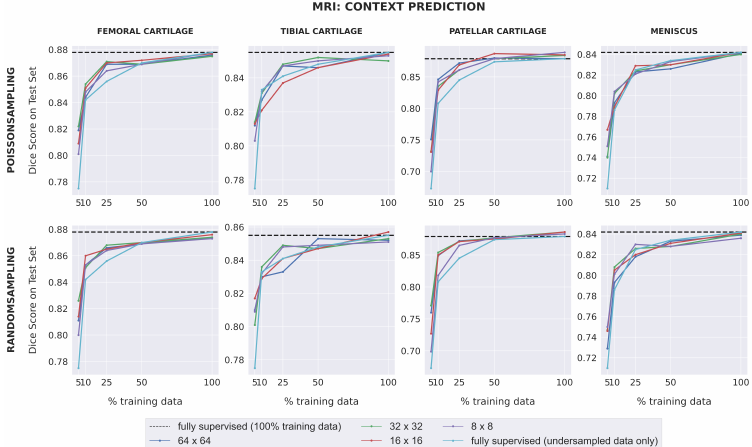
Figure A2. The downstream segmentation performance on the MRI dataset for the Context Prediction pretext task as measured by the Dice score for every combination of patch size and sampling method used during pretraining, evaluated in five different scenarios of training data availability. In each scenario, every model is trained for segmentation using one of the five different subsets of training data as described in Section 2.1.1. The black dotted line in each plot indicates the performance of a fully-supervised model trained using all available training images. The light blue curve indicates the performance of a fully-supervised model when trained using each of the five different subsets of training